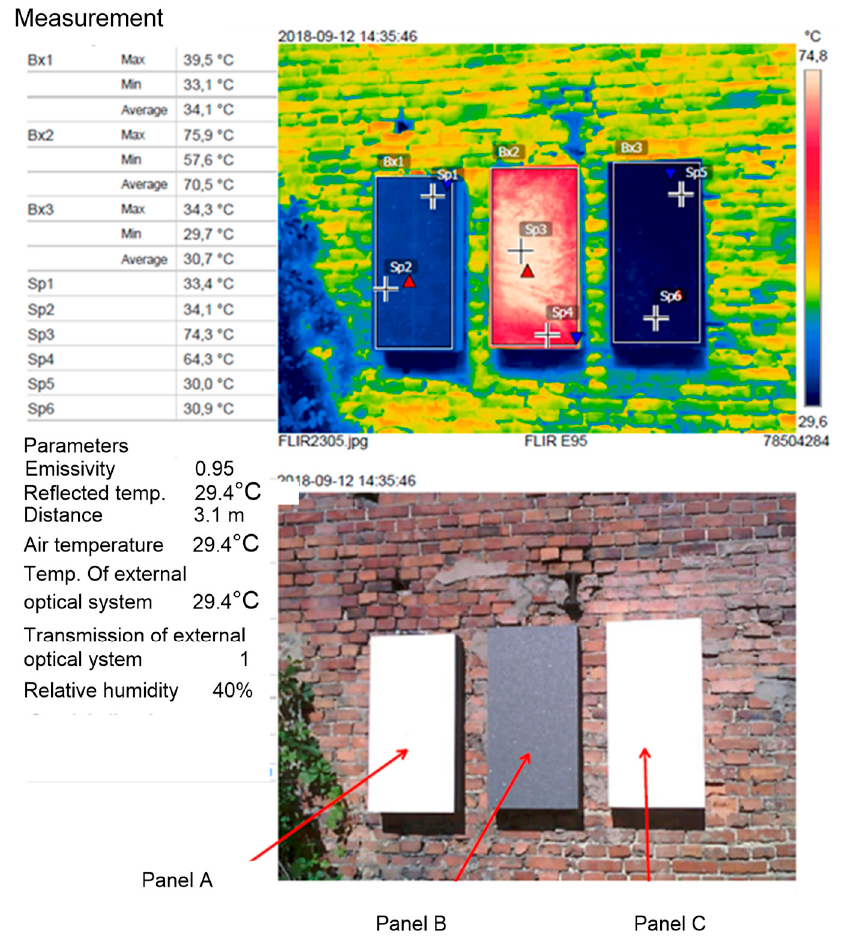
Figure 11. Temperature measurements made for three polystyrene boards. Average wind speed: 1.6 m /